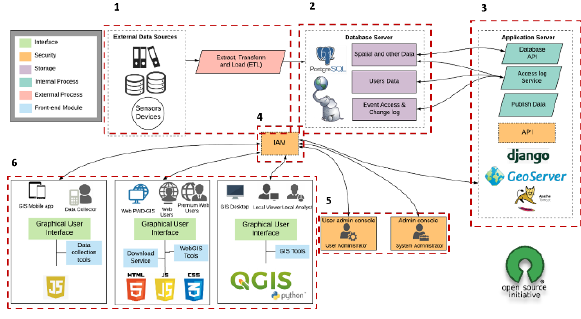
Figure 2. Subsystems schematic